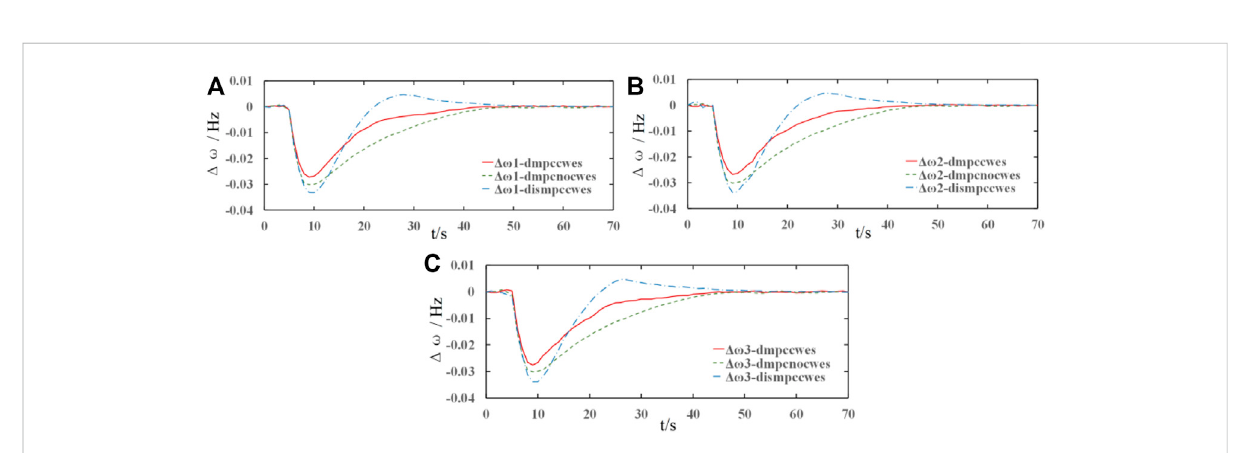
green dotted lines show the response results under the DMPC strategy without the CWES system, and the blue dashed curves display the response performance of the distributed MPC algorithm. The test data results in case A are listed in Table 3, and Δ f max is the maximum average value of frequency fl uctuation and t stable is the average period for frequency to recover to stable